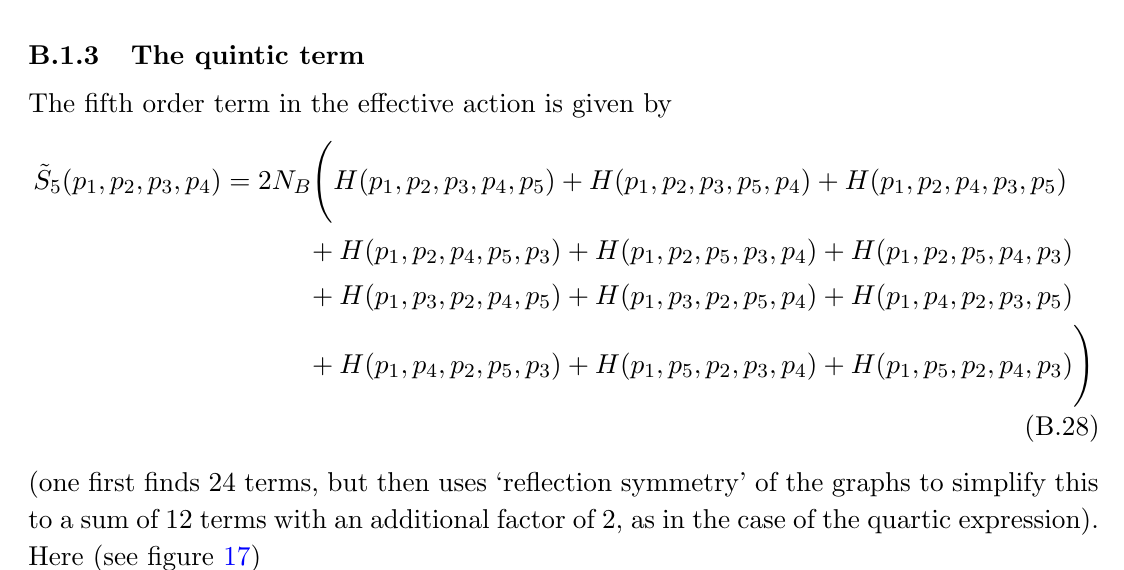
p 4 p 5 (cid:0) (cid:0)